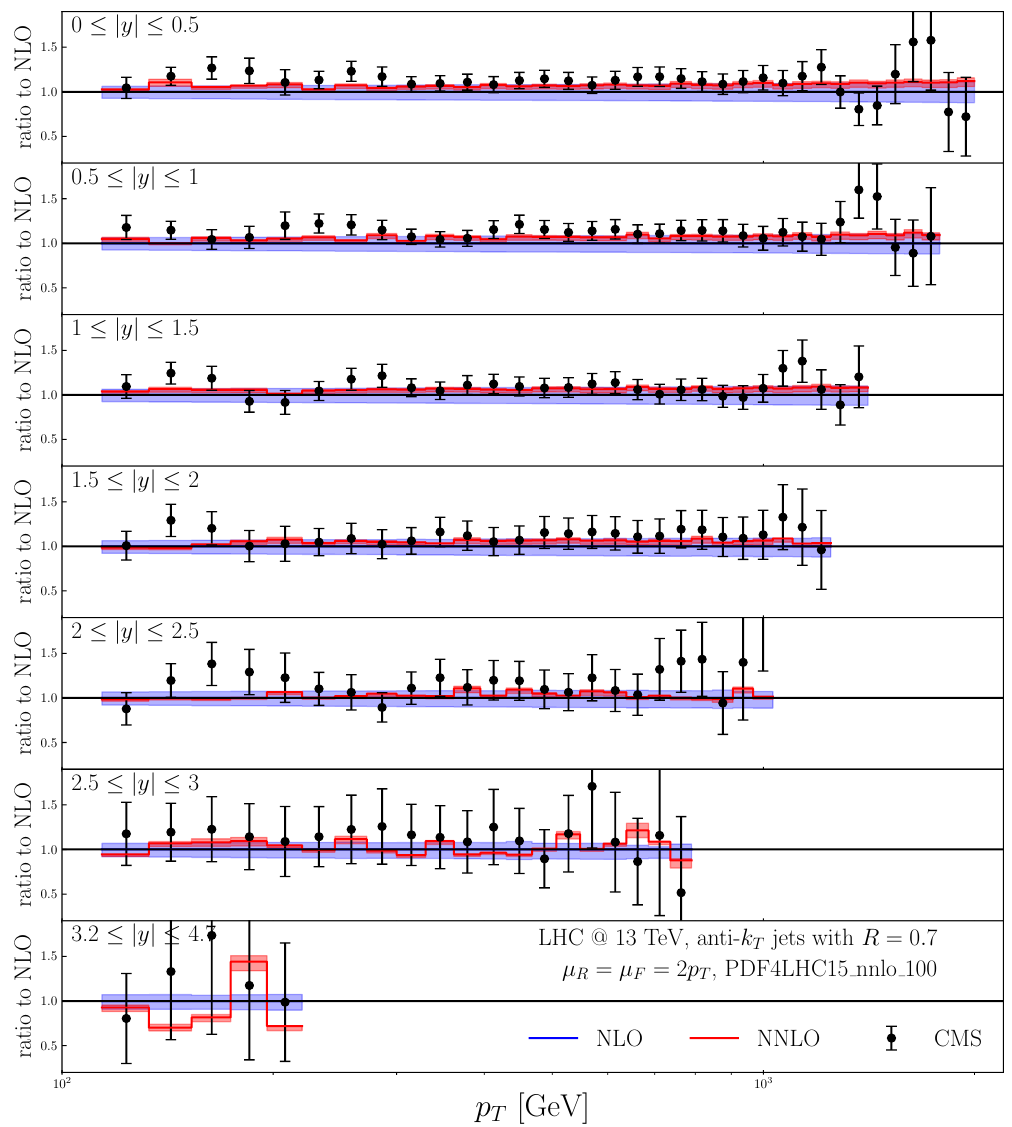
Figure 2 . Double-di(cid:11)erential single jet inclusive cross-sections as measured by CMS [1] and NNLO perturbative QCD predictions as a function of the jet p T in slices of rapidity, for anti- k T jets with R = 0.7 normalised to the NLO result. Both perturbative predictions, NLO and NNLO, have been obtained with the PDF4LHC15 nnlo PDF set and with (cid:22) R = (cid:22) F = 2 p T . The shaded bands represent the scale uncertainty obtained from di(cid:11)erential distributions evaluated at (cid:22) R = (cid:22) F = p T and (cid:22) R = (cid:22) F = 4 p T